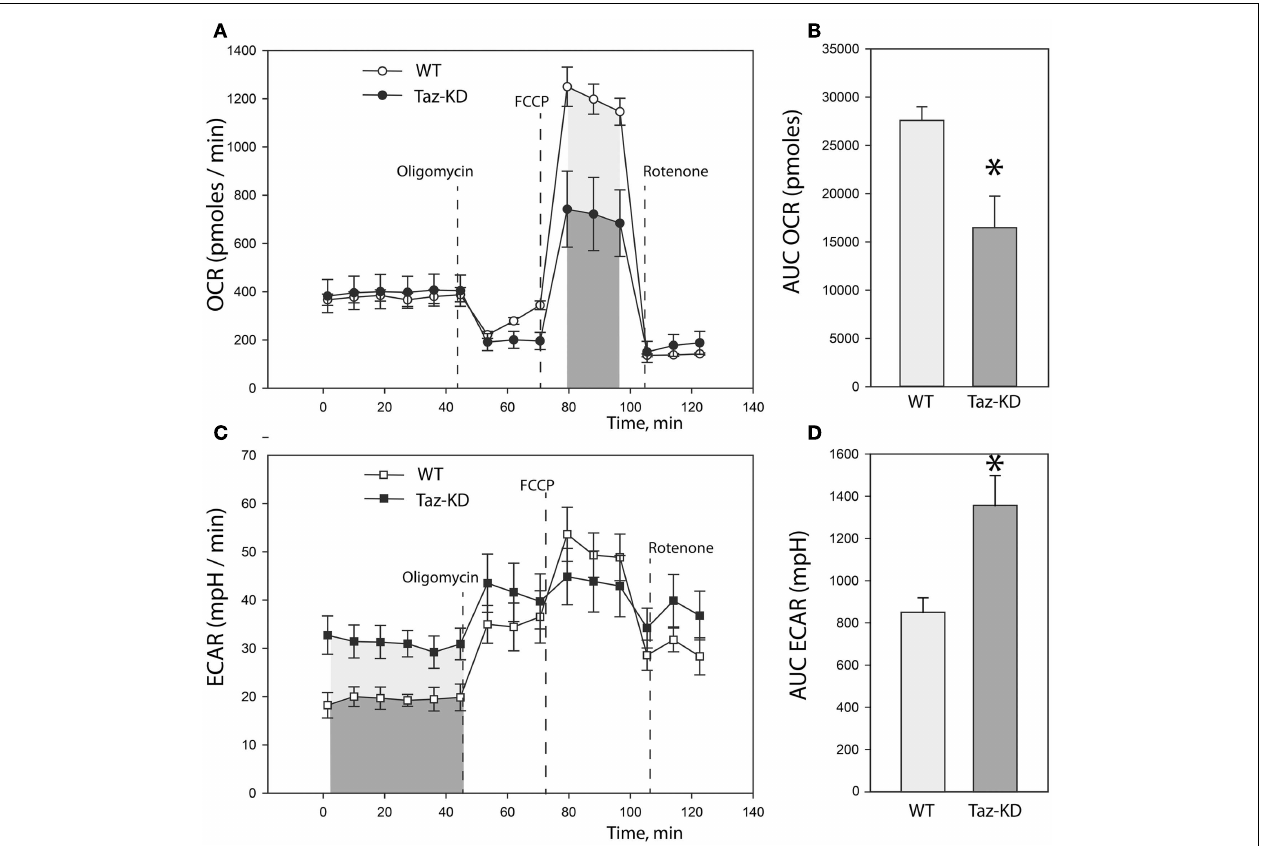
curve (AUC) of FCCP-stimulated respiration trace [shaded areas on (A) ]. (C) Extracellular acidification rates (ECAR) ofWT andTaz-KD neonatal cardiomyocytes. ECAR rates, expressed as mpH per min inWT andTaz-KD cardiomyocytes and normalized to cell numbers. (D) ECAR values at basal conditions were significantly higher forTaz-KD cardiomyocytes ( *p < 0.002 ), consistent with an increase reliance ofTaz-KD cells on glycolysis. Extracellular acidification values were determined by calculating AUC of ECAR tracing at basal metabolic state [shaded areas on (C) ].The differences in means in (B,D) were assessed byTukey’s post-hoc test.